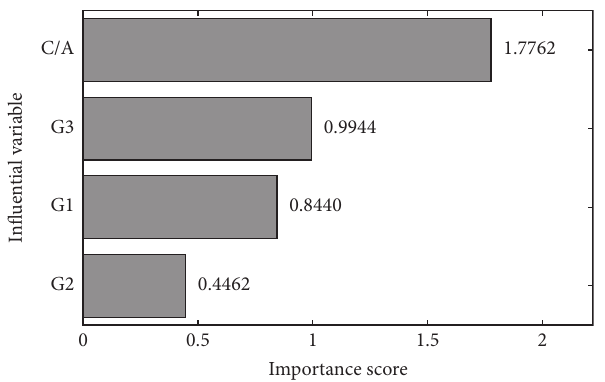
Figure 8: Importance score of the four design